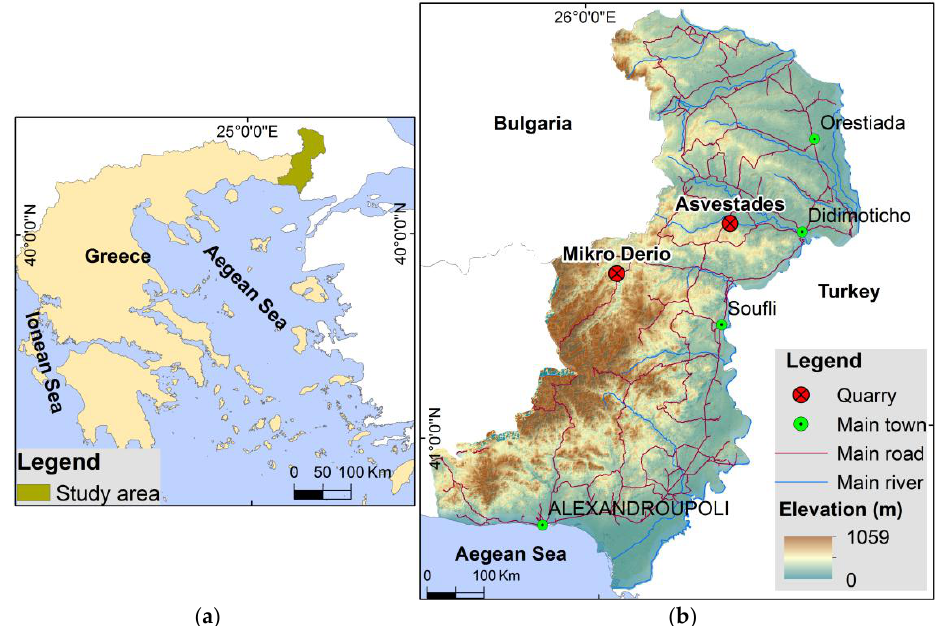
Figure 1. ( a ) Location map of the region of Evros; and ( b ) the location map of the quarries of Asvestades and Mikro Derio with elevations, main towns, main drainage network, and main road network.